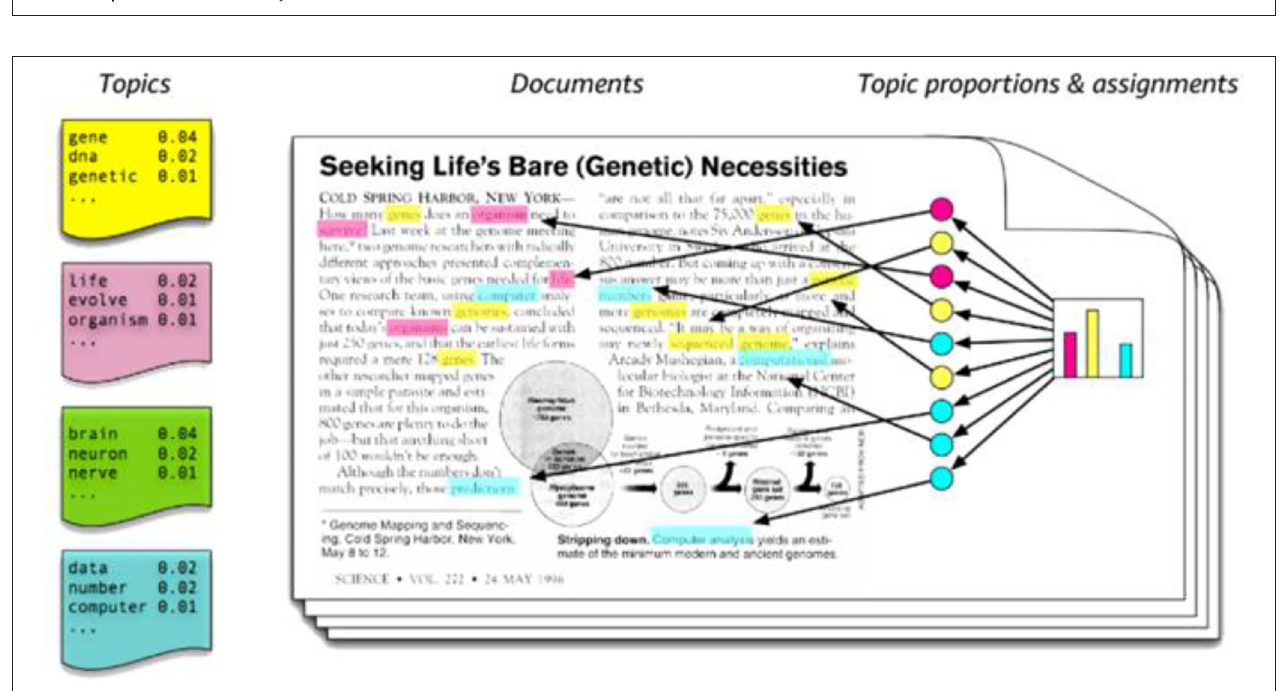
FIGURE 2 | The overview of topic modeling process